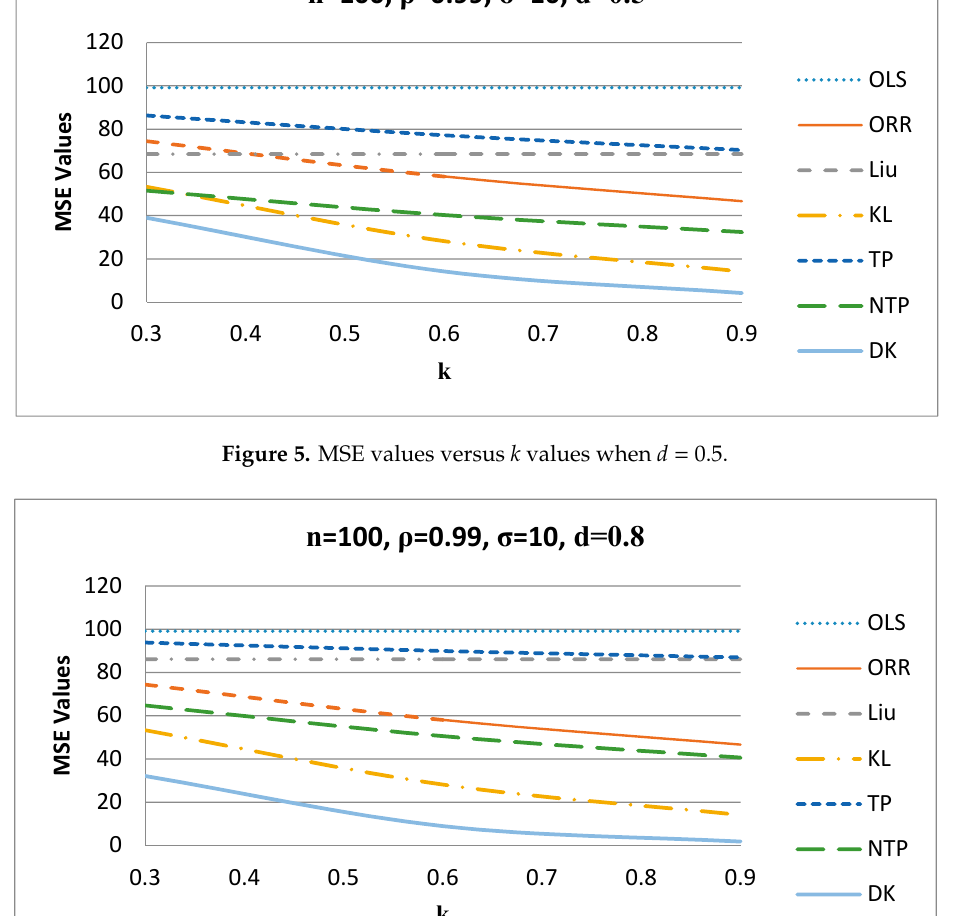
Figure 6. MSE values versus k values when d =